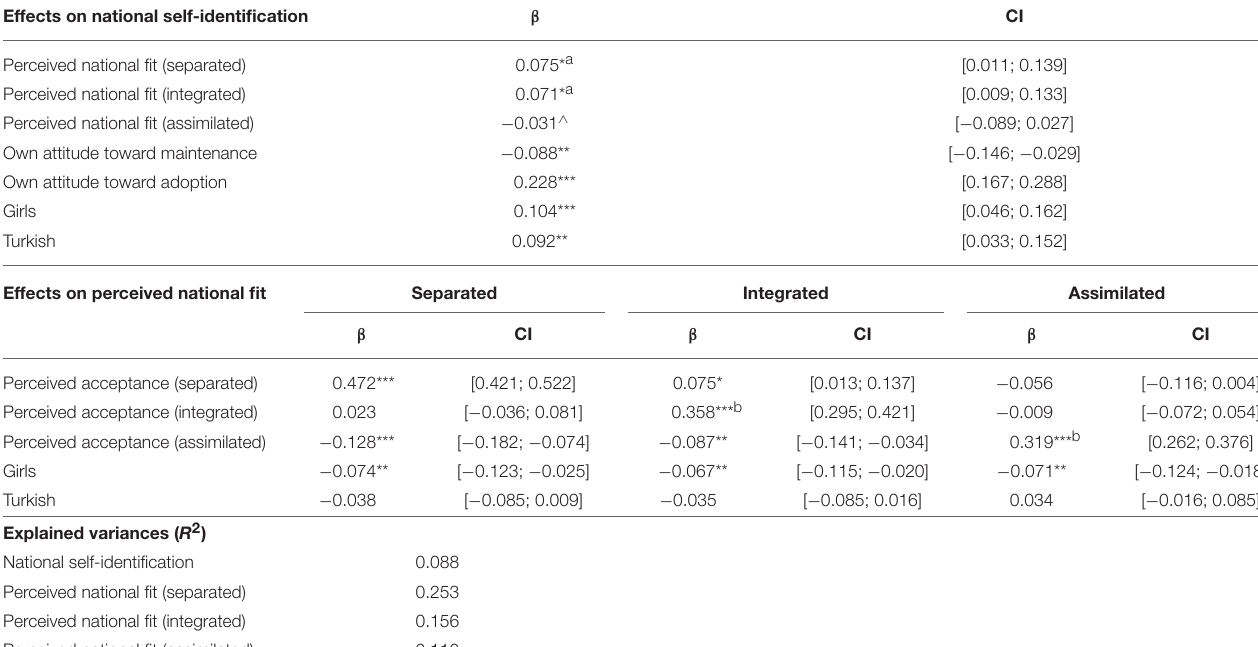
TABLE 2 | Multi-level path model with national self-identification as the final dependent variable and while controlling for students nested in school classes. Effects on national self-identification